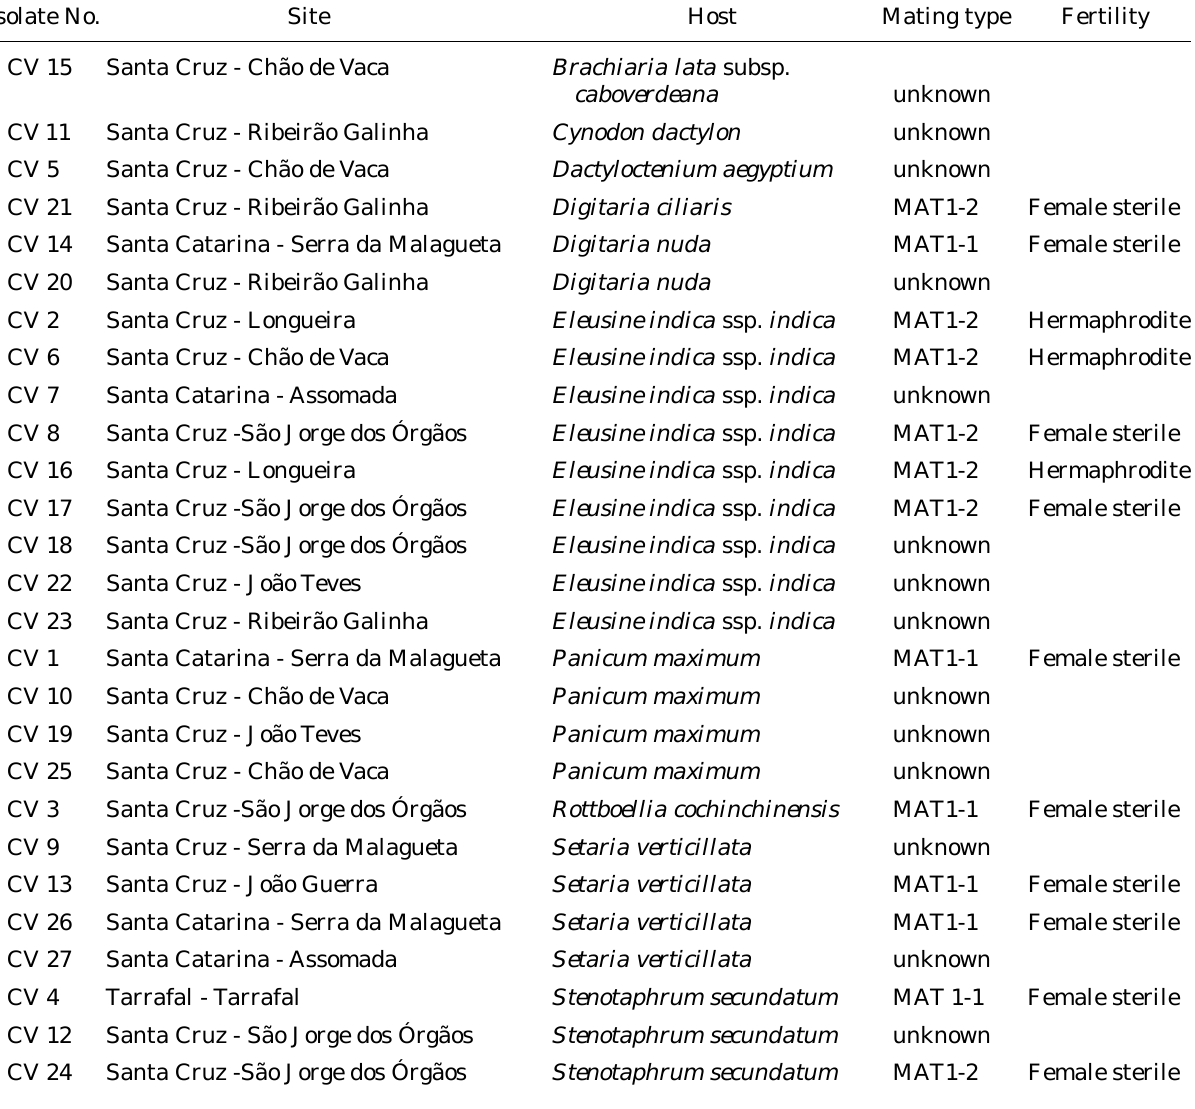
Table 1. Host, mating type and fertility for Magnaporthe grisea isolates from Santiago Island, Cape Verde. Isolate No. Mating type